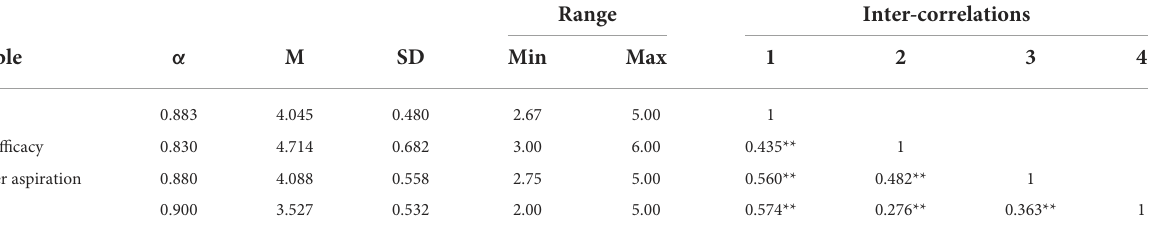
TABLE 1 Means, standard deviations, Cronbach alpha, and correlations of main variables.